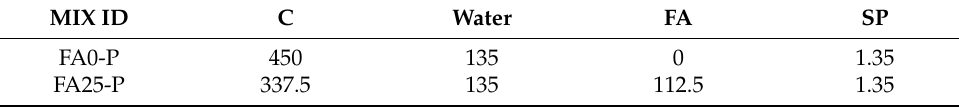
Table 5. Mix proportions of paste (kg/m 3